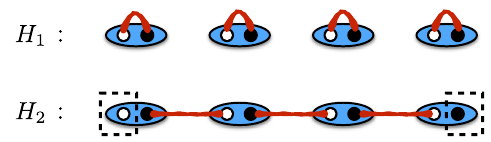
FIG. 1. Schematic picture of stroboscopic Floquet drive. The phase with Floquet Majorana edge states is obtained by alter- nating time evolution with a trivial Hamiltonian H 1 for time T 1 followed by time evolution under a topological Hamiltonian H 2 for time T 2 . Complex fermions c into two Majorana fermions a respectively). Nonzero couplings are represented by wavy red